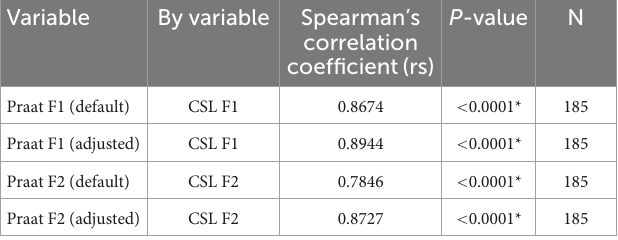
TABLE 4 Spearman’s rank correlations of F1 and F2 data of the five Japanese vowels calculated by Computerized Speech Lab (CSL) to those calculated using the default and adjusted settings of